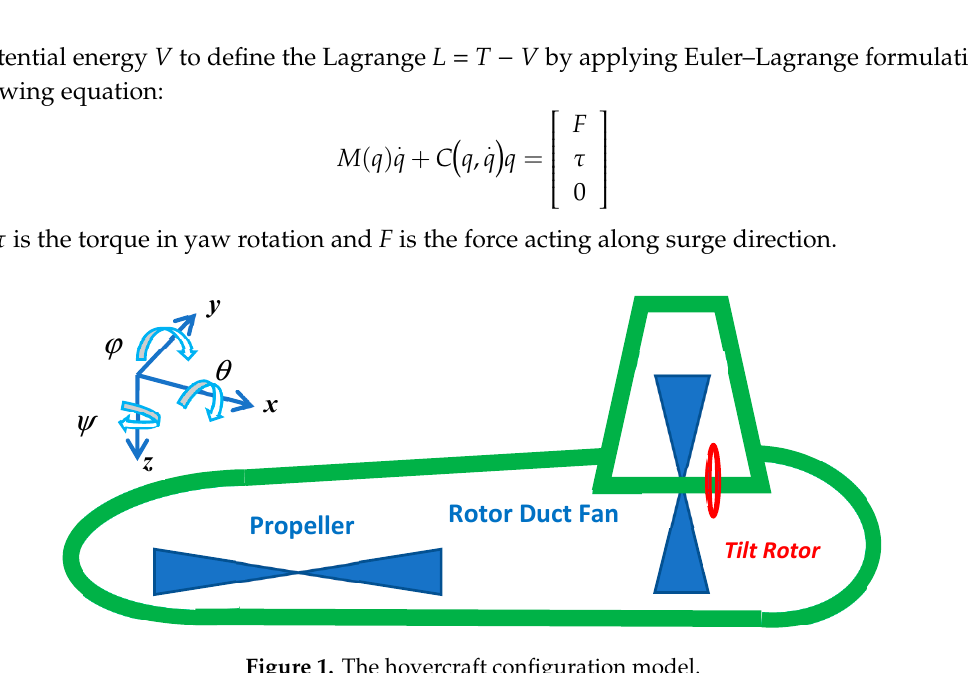
Figure 1. The hovercraft configuration model.